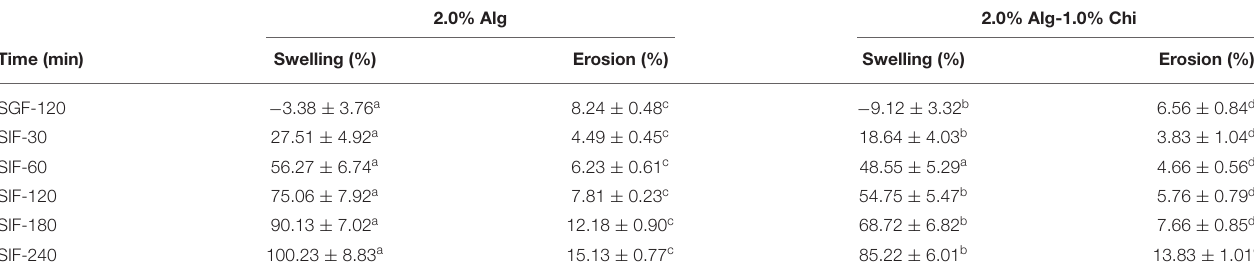
TABLE 2 | The swelling and erosion degrees of alginate hydrogel beads and alginate-chitosan hydrogel beads during gastric digestion and intestinal digestion.